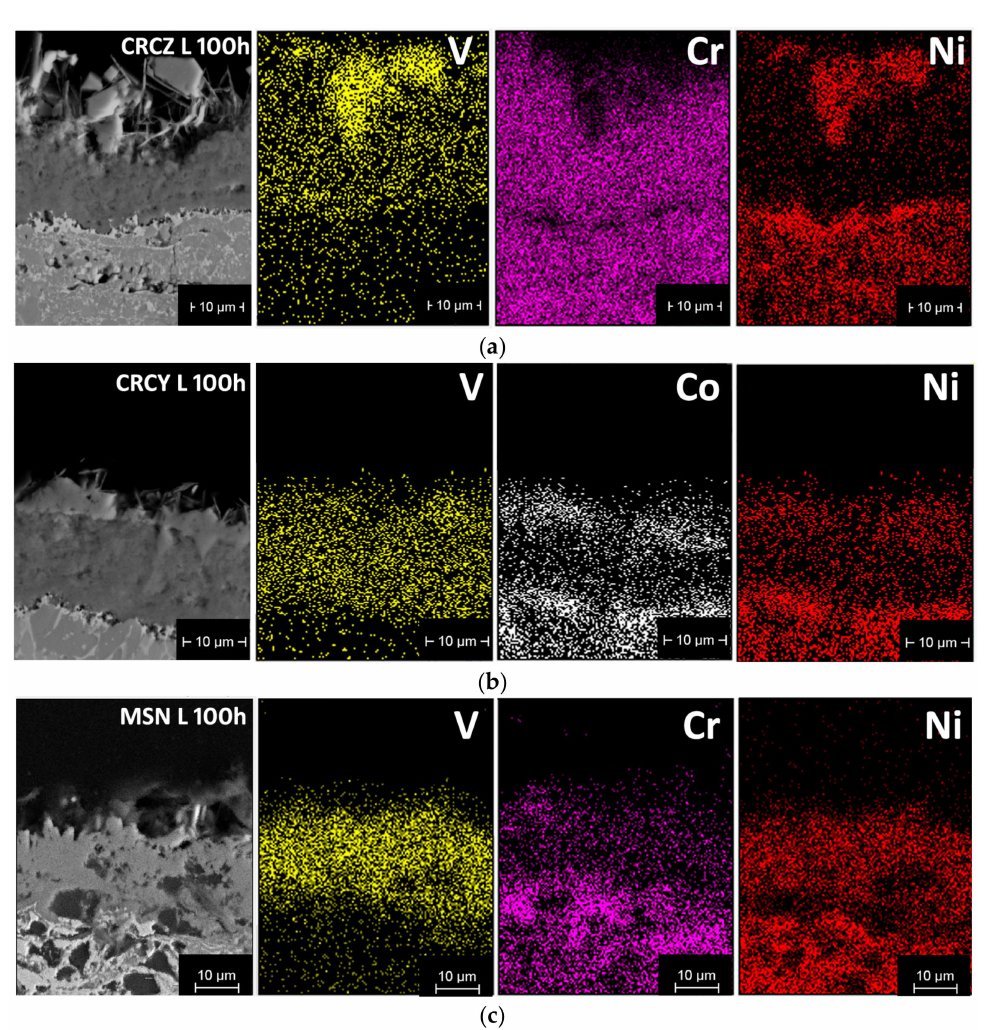
Figure 11. EDS analysis of the corrosion scale for laser-treated samples, after 100 h of the corrosion test: ( a ) CRCZ; ( b ) CRCY; and ( c )